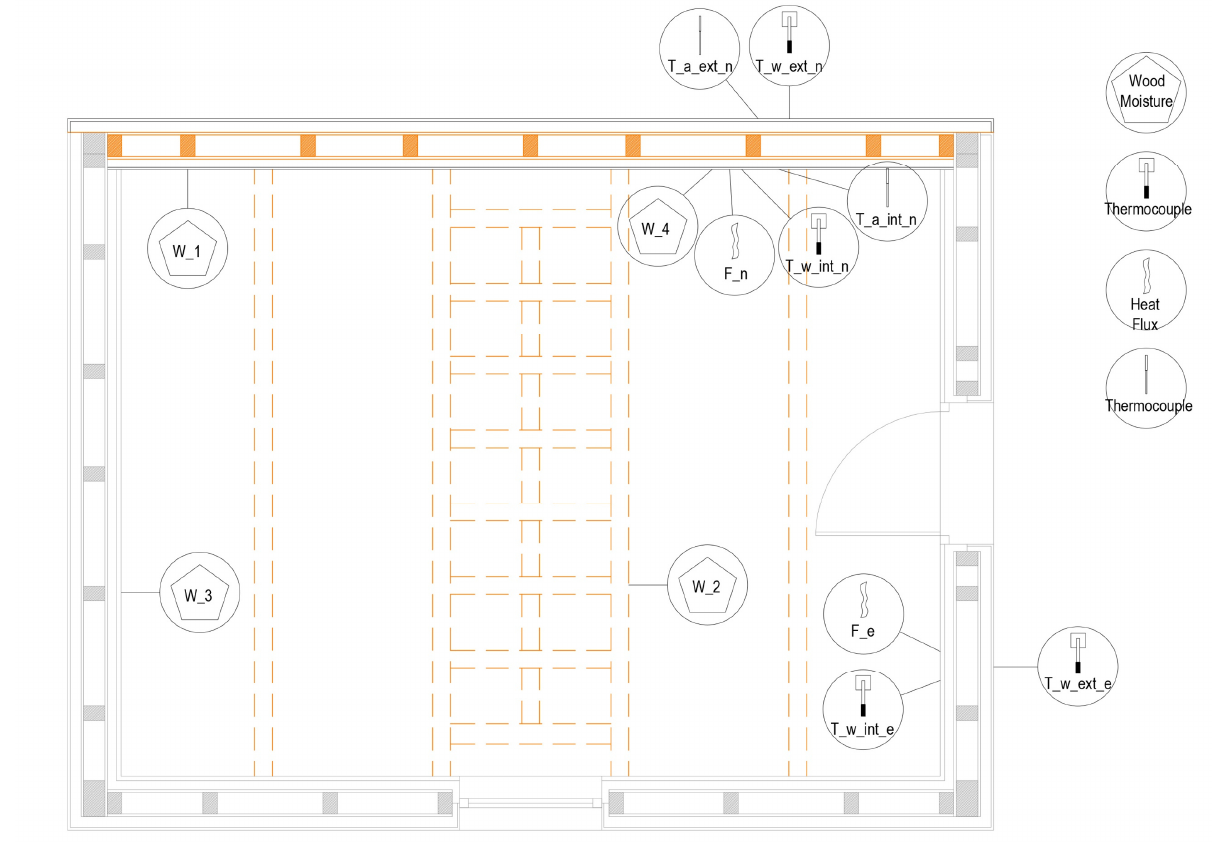
Figure 5. Plan view with the different sensors positioned in the test